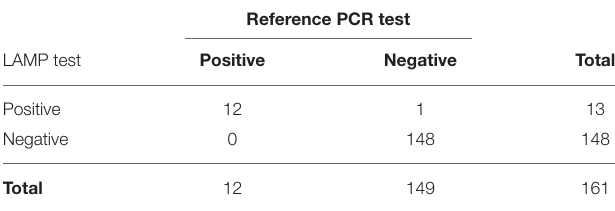
TABLE 4 | Comparison of diagnostic results by LAMP vs. real-time